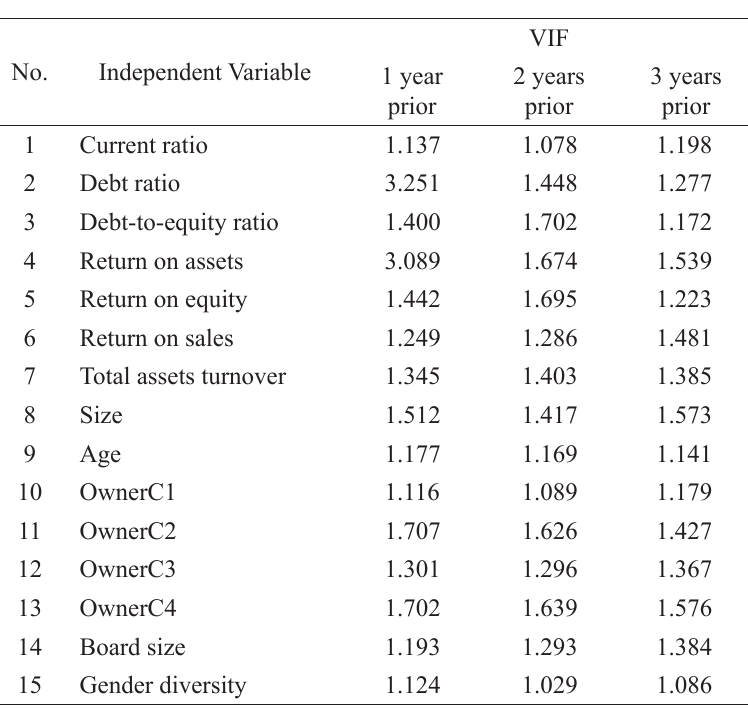
Variance Inflation